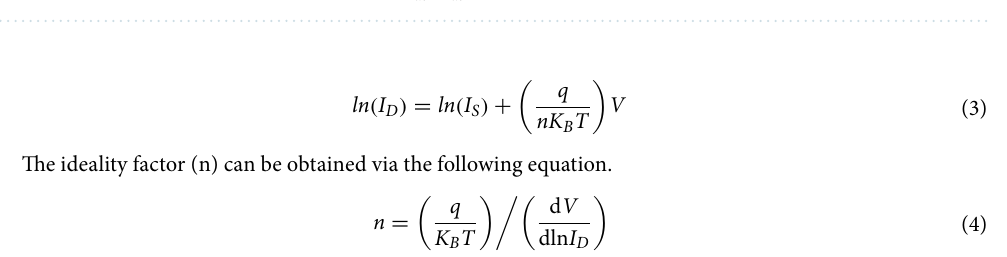
Figure 2. (a) The transfer characteristics of p-GeSe. (b) n-MoSe 2 . (c) The linear I ds –V ds curves of p-GeSe shows ohmic behavior with Pd/Au, and (d) the linear I ds –V ds curves of n-MoSe 2 also show ohmic behavior with